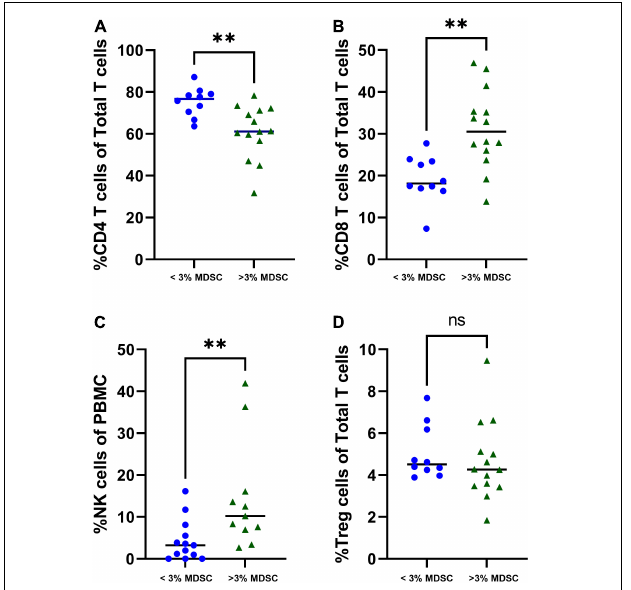
FIGURE 4 | Associations with T-MDSC and immune cells in patients with symptomatic COVID-19. Increased frequencies of T-MDSC were associated with (A) decreased percentage of CD4 + T cells, and increased percentages of (B) CD8 + T cells and (C) NK cells. (D) There were no significant associations between T-MDSC frequency and percentage of T regulatory cells. < 3% MDSC ( N = 10), > 3% MDSC ( N = 14). Mann-Whitney test was performed, data represent medians with IQR values. ∗∗ p -value < 0.01.